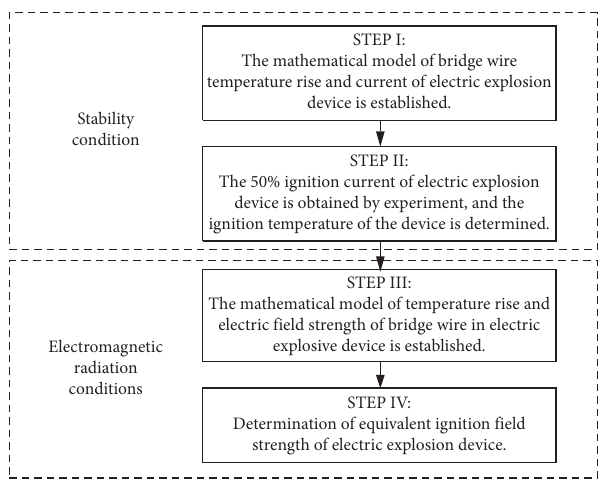
Figure 1: The design process of the equivalent test method for electromagnetic radiation effect of